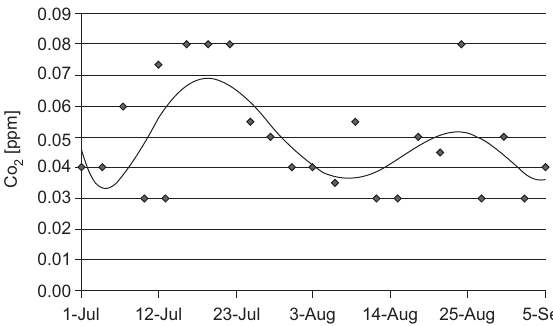
Fig. 10. Concentration of biogenic CO biocoenoses in the area of Kaffiøyra plain in the period 1.07–5.09.2004; trend of the 6th order